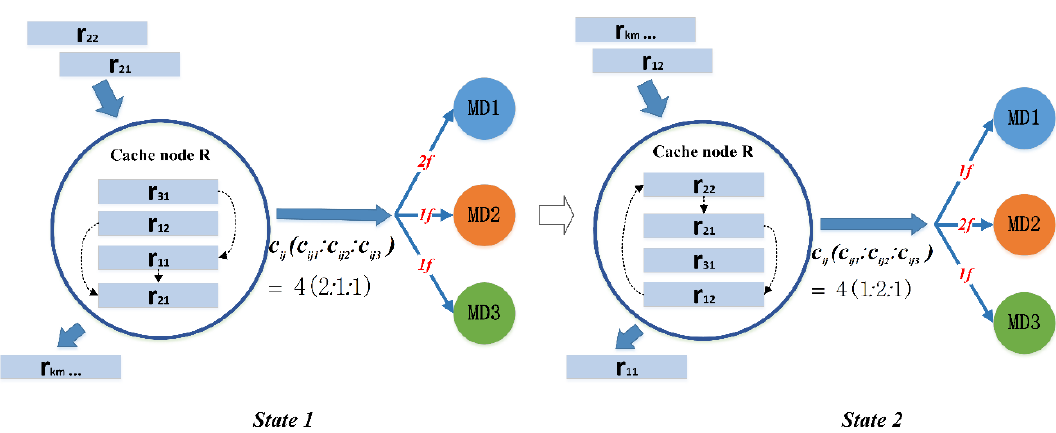
Figure 6. Changing the cache algorithm to adjust the transmission capacity of the edge. States 1 and 2 are two cached storage states, 𝑟 𝑘𝑚 above R is the data block to be cached, 𝑟 𝑘𝑚 below R is the data block to be cached out, and the dotted line represents that the new data block entering R will change the internal cache block configuration state. On the edge, there is total transmission capacity 𝑐 𝑖𝑗 and maximum transmission capacity 𝑐 𝑖𝑗𝑘 of each 𝐷 𝑘 in this state. In the examples, 1f and 2f represent the allocated data flow for each type of data 𝐷 𝑘 on the edge (𝑅 𝑀 , 𝑀𝐷 𝑘 ) .